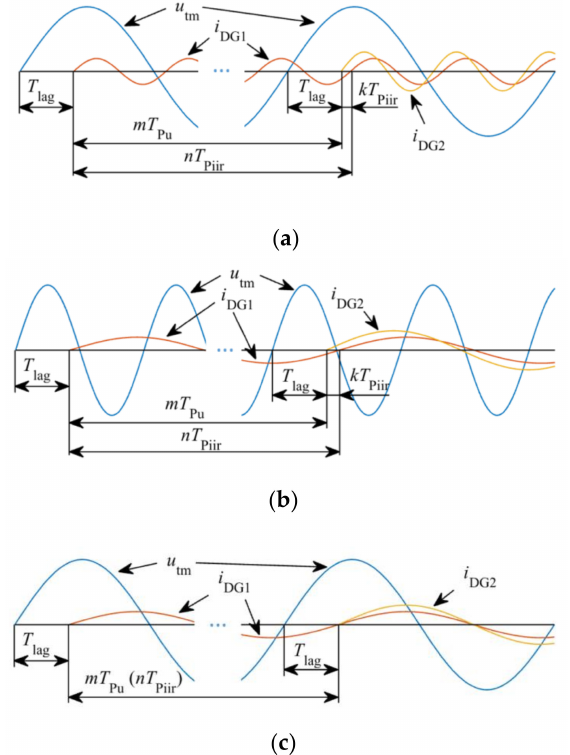
Figure 3. Scenarios that two irregular currents are injected. ( a ) High-frequency currents; ( b ) Low-frequency currents; ( c ) Negative sequence fundamental frequency